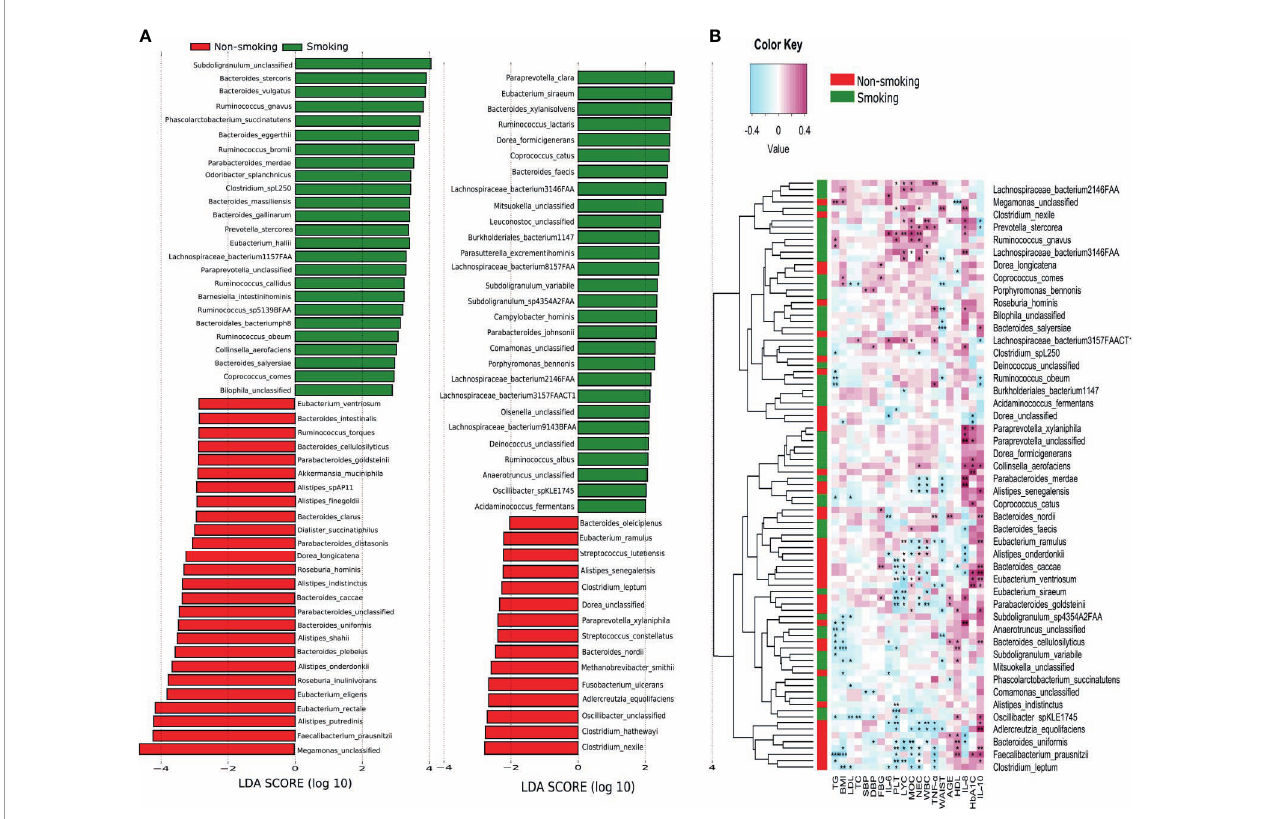
FIGURE 3 | LEfSe and Spearman correlation analysis (A) LEfSe analysis shows microbial species with LDA scores >2; (B) Spearman correlation analysis showing the correlations between species abundances and participant characteristics. * P < 0.05, ** P < 0.01, *** P <